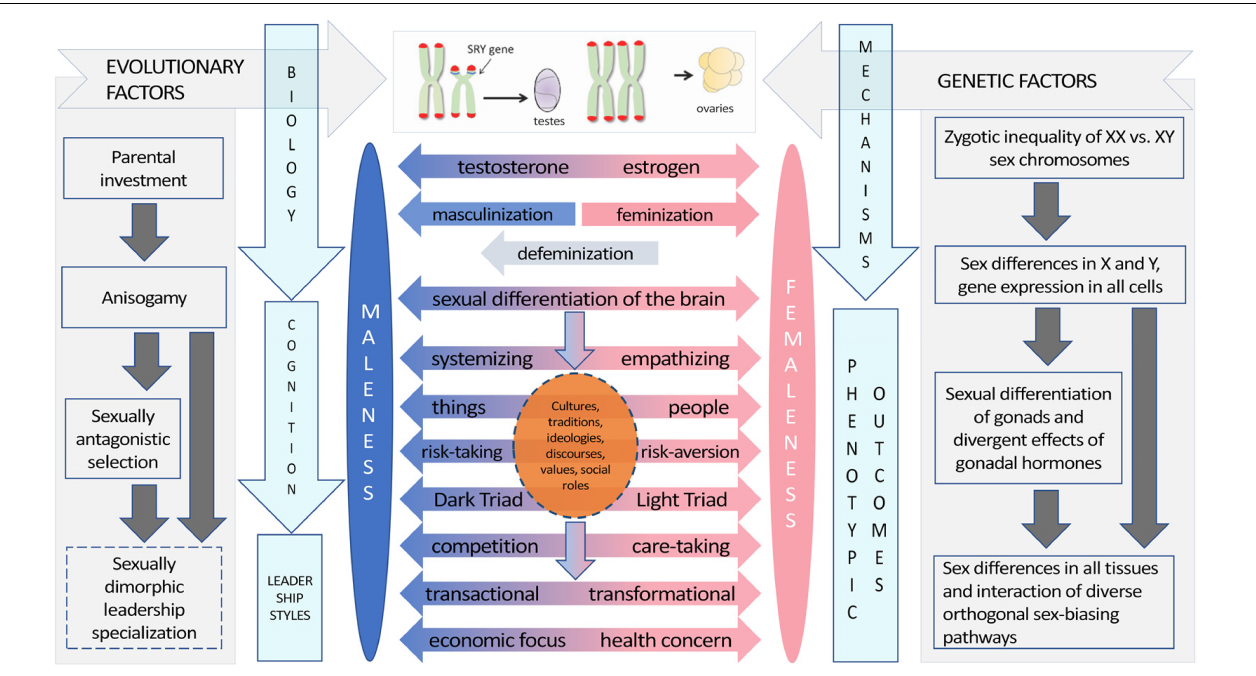
FIGURE 1 | The evolutionary–developmental origins and proximate mechanisms underlying psychobehavioral sex differences, including those in leadership. Sexually dimorphic leadership specialization is included as a new hypothesis, not as an established fact. Figure adapted from Luoto et al. (2019a), Arnold (2020), McCarthy (2020), and Malmi